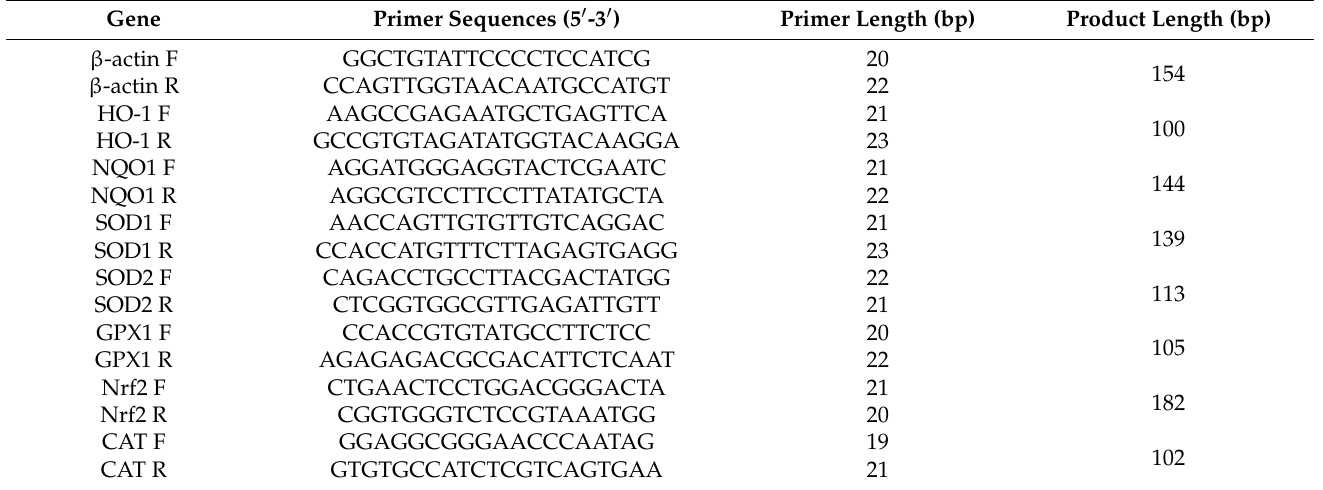
Table 1. Primer sequences used for quantitative